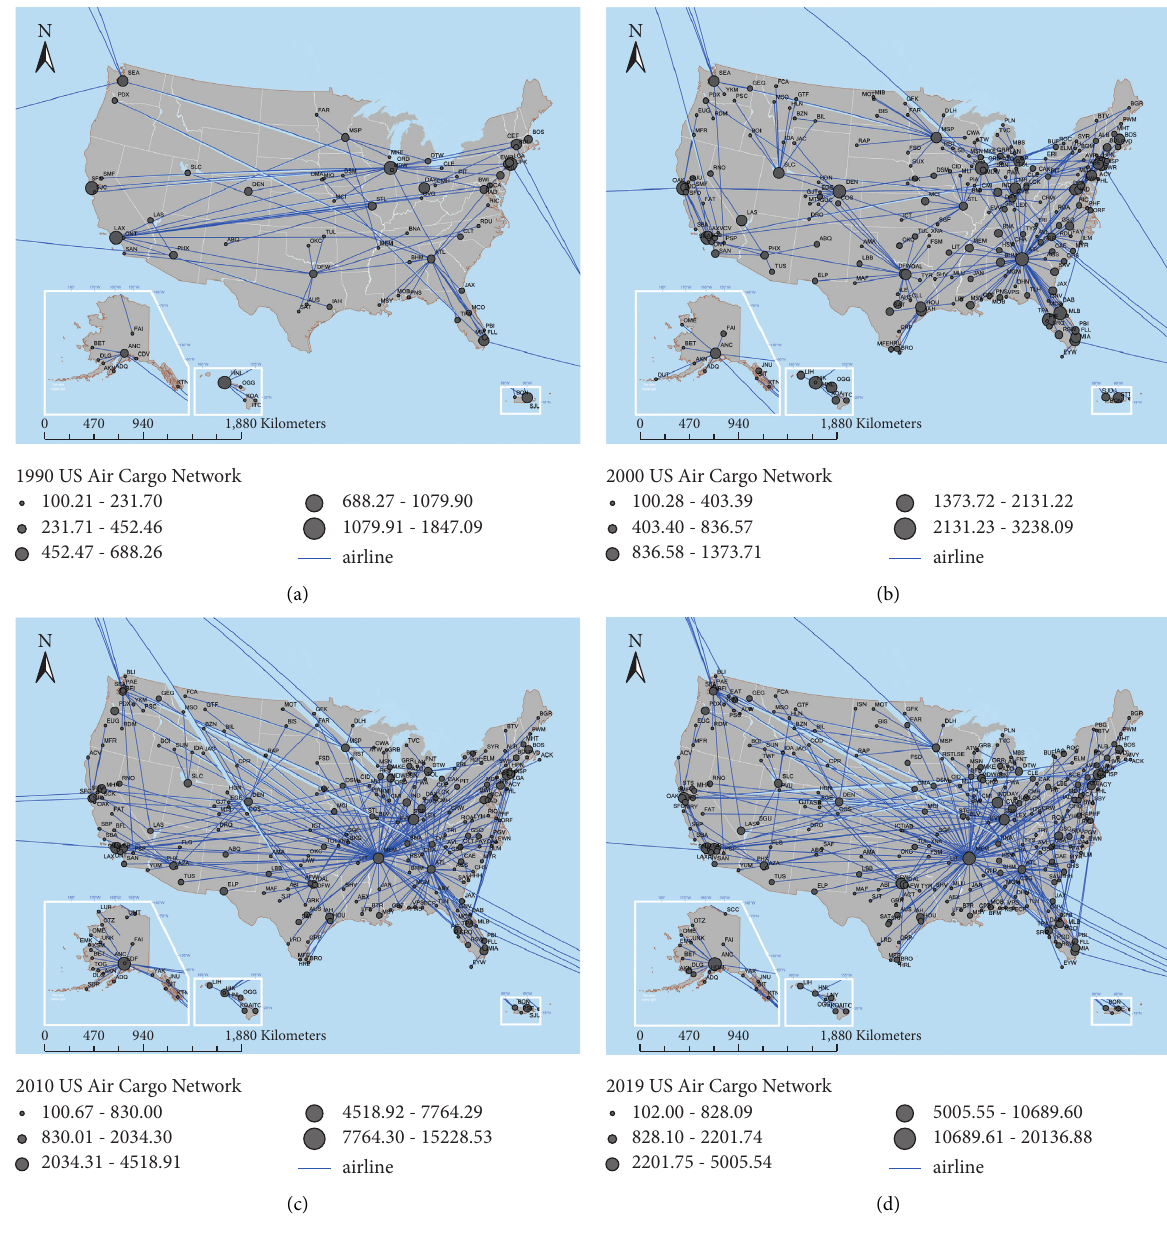
Figure 2: Evolution of the USACN network structure from 1990 to 2019. Table 2: Rankings of the US air cargo airports based on complex network metrics in